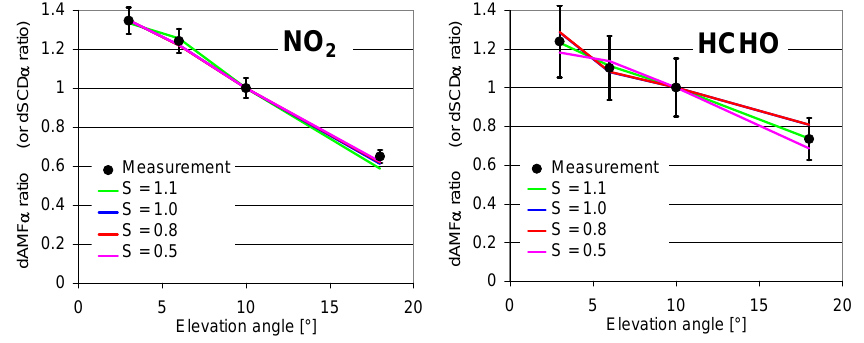
Fig. 7. Comparison of measured ratios of the NO 2 and HCHO dSCD α (or dAMF α ) relative to the 10 ◦ elevation (black dots) to the respective results of the forward model (coloured lines) for the southern telescope (19 September 2003, 08:00). The different colours indicate fit results for different profile shapes. The error bars indicate the errors of the spectral analysis.